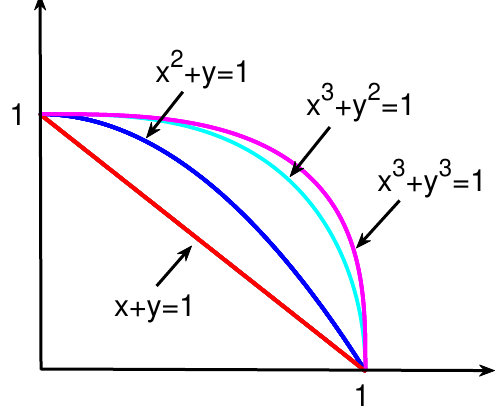
Figure 1. Some grade spaces of ( m , n )